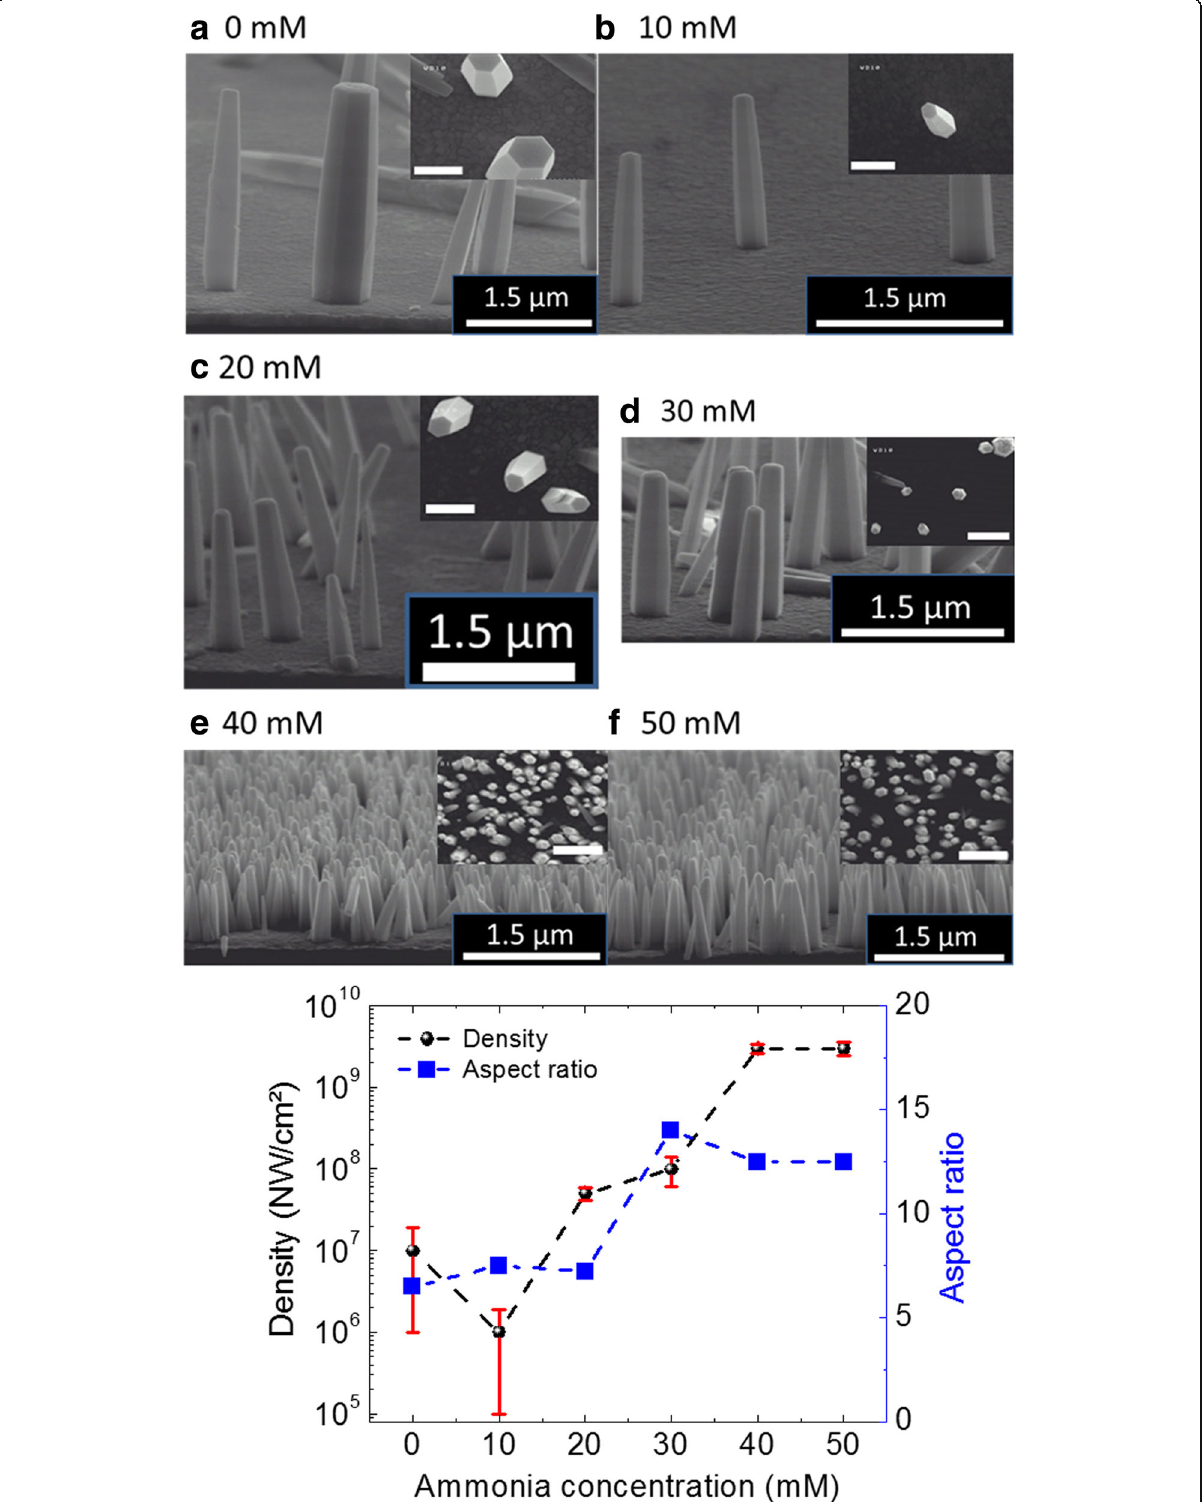
Fig. 1 SEM images of NWs grown for different concentrations of ammonia. a 0 mM, b 10 mM, c 20 mM, d 30 mM, e 40 mM, and f 50 mM. The inset in each panel ( a – e ) shows the top-view SEM image acquired from the same sample. The scale bar in the inset is 500 nm. g The variation of density and aspect ratio of NWs with the change in NH 4 OH